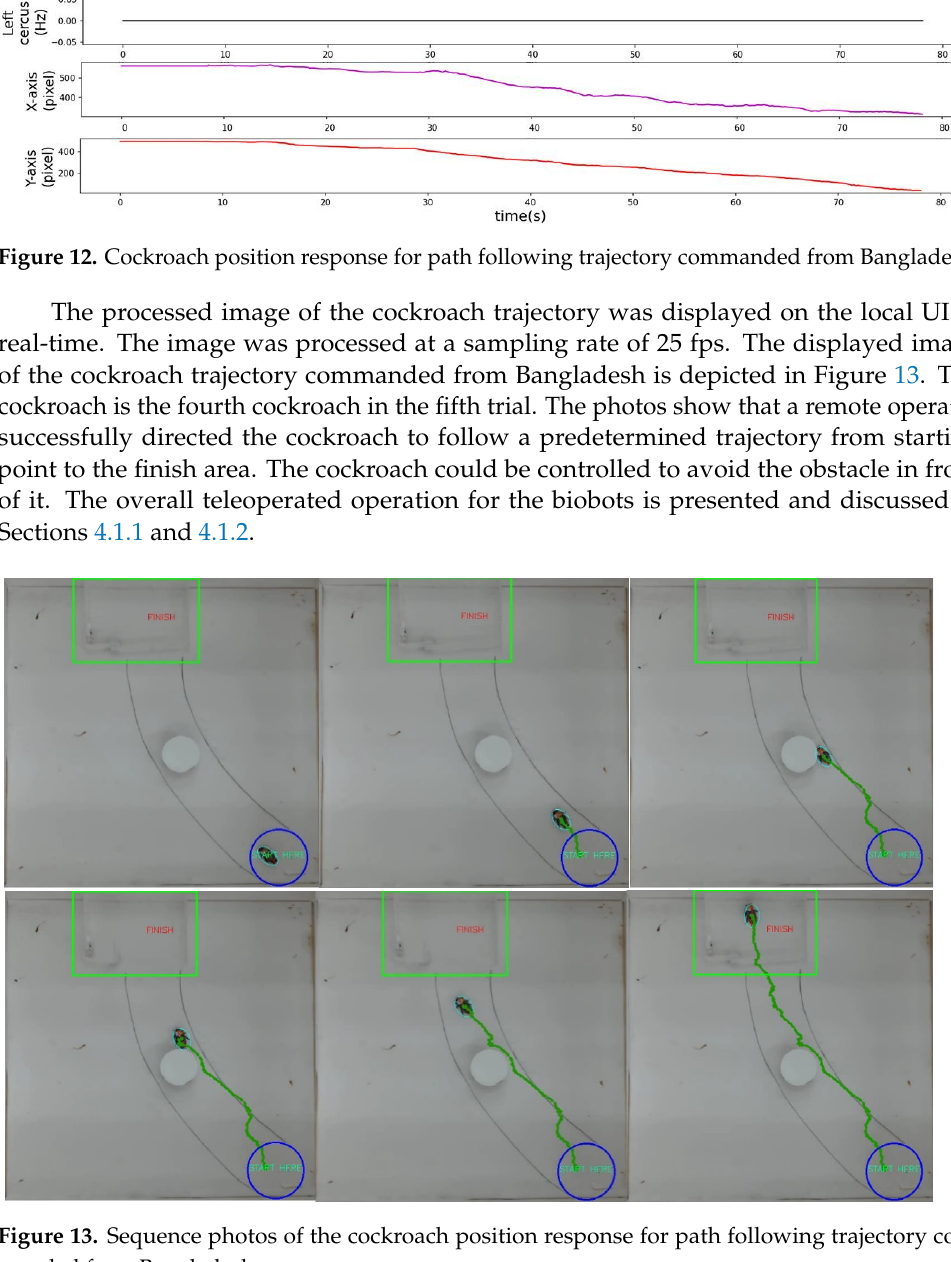
Figure 11. Cockroach attitude angle response for path following trajectory commanded from Bang- ladesh.